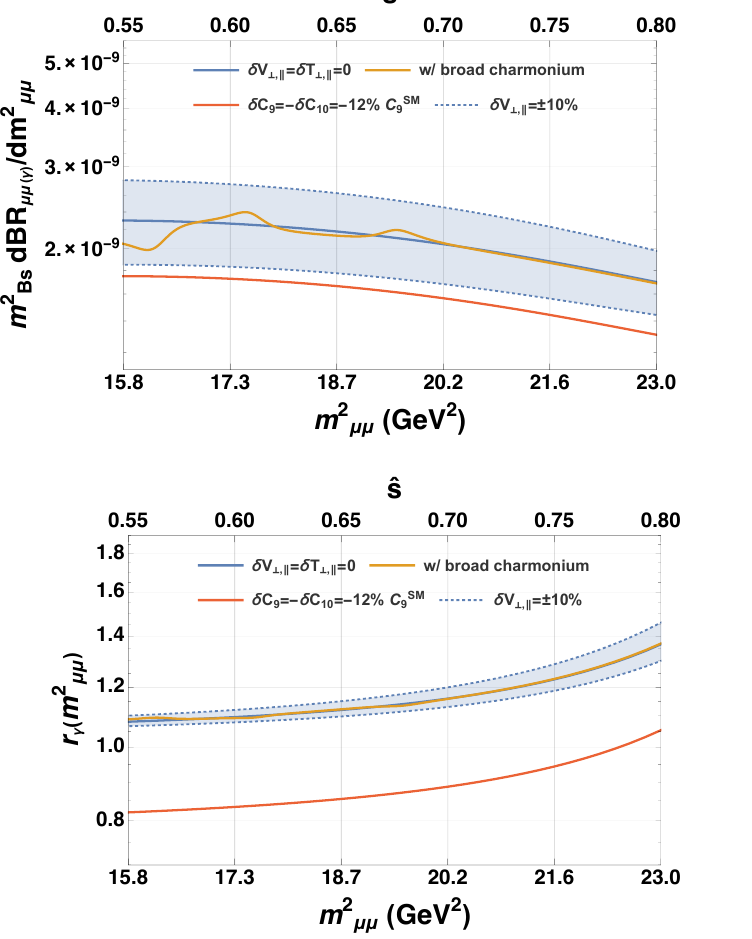
Figure 4 . Comparison between (left panel) the theoretical error in the B 0 and (right panel) the corresponding error on r (cid:13) as de(cid:12)ned in eq.